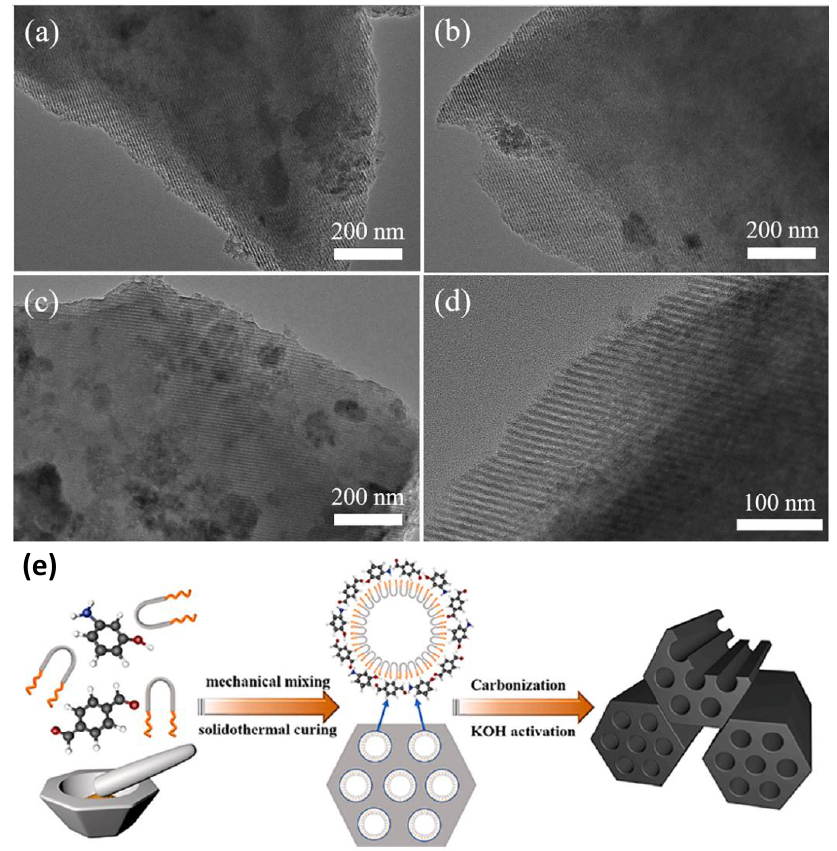
Figure 6. ( a – d ) Solidothermal synthesis of nitrogen-decorated ordered mesoporous carbons with large surface areas was analyzed by TEM characterization, ( e ) Synthesis scheme of K-N-OMC-T. Reproduced with permission [131] . Copyright © 2022, Chemical Engineering Journal.